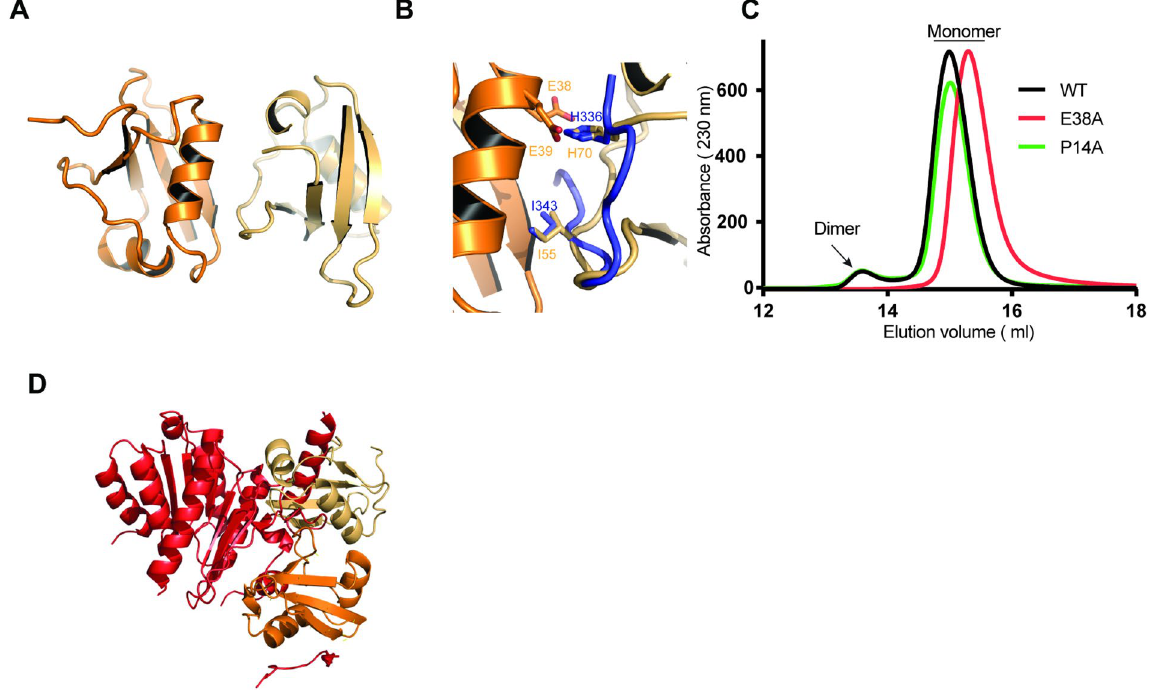
Figure 5. Structural analysis of UFM1 crystal structure. ( A ) Crystal structure of UFM1 showing the beta grasp fold commonly observed in ubiquitin and other UBLs. The asymmetric unit contains two molecules of UFM1. ( B ) Contact between two UFM1 molecules in asymmetric unit mimics the UIS binding to UFM1. Superposition between UFM1-UIS structure and UFM1 alone; the UIS is in blue. The spatial position of UIS H336 and I343 overlap with UFM1 H70 and I55, respectively. ( C ) Gel filtration elution profiles of UFM1 WT or mutants. ( D ) Superposition of UFM1 dimer (orange) with UBA5-UFM1 complex. UBA5 (red) holds the UFM1 dimer in an orientation that generates clashes with the UFM1 molecule that does not interact with the UIS and the adenylation domain, thereby preventing charging of UFM1